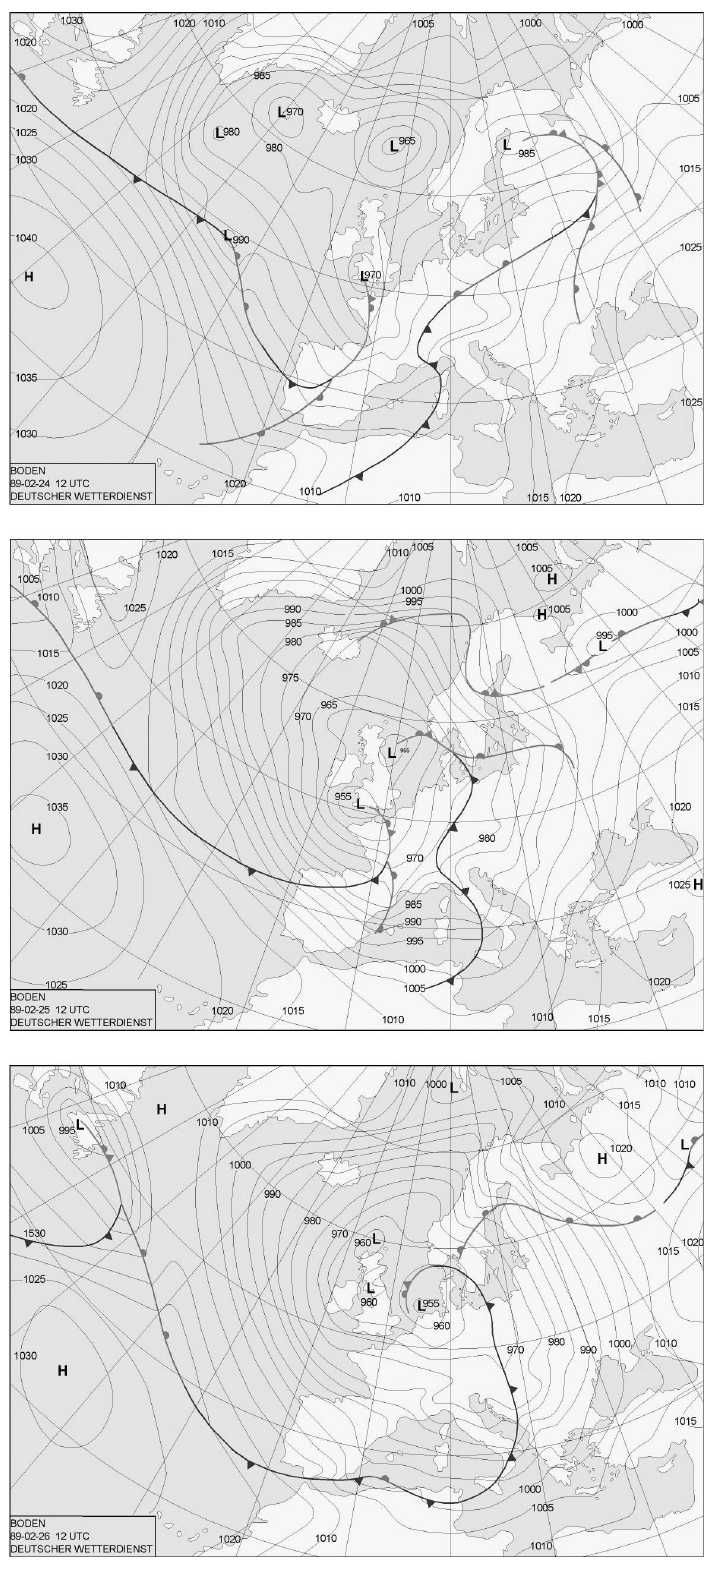
Fig. 2. Successive synoptic charts for 24 (top), 25 (middle) and 26 (bottom) February 1989, 12:00 GMT (according to Deutscher Wetter-